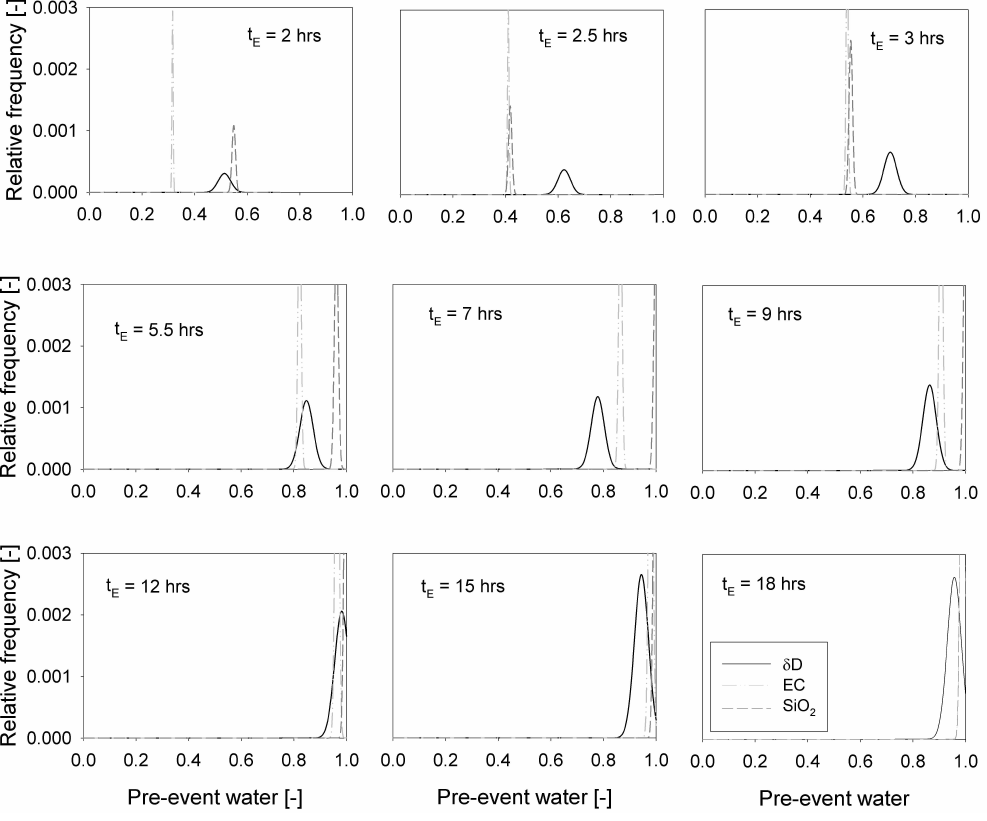
Fig. 7. Probability distributions of pre-event contributions computed with 3 different tracers ( δD , EC and SiO 2 ) for the available samples of the M5 event. t E denotes the time elapsed since the beginning of the event